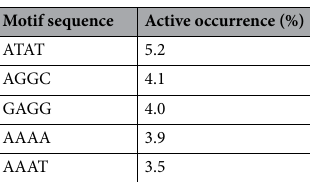
6 -methyladenine site